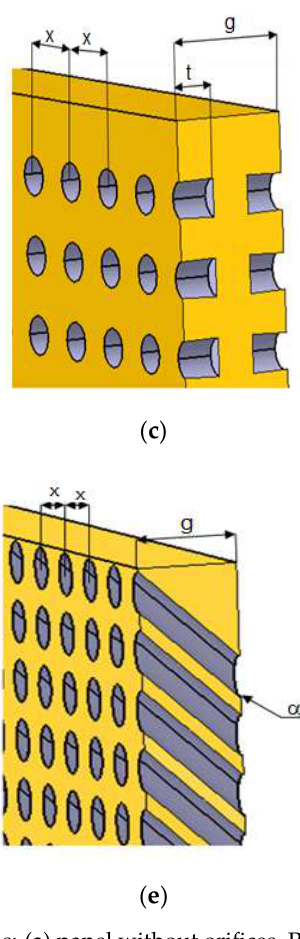
Figure 1. Design of thermal insulation materials with different geometries of channels: ( a ) panel without orifices, P0; ( b ) panel with perforated horizontal channels, P1; ( c ) panel with partly perforated symmetric channels, P2; ( d ) panel with partly perforated alternative channels, P3; ( e ) panel with perforated inclined channels with an angle α = 45°, P4. Legend: g is panel thickness; t is the channel length; x is the distance between two adjacent channels and α is the angle of inclined channels.